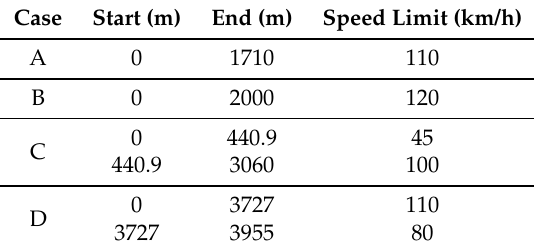
Table 4. Speed limits.